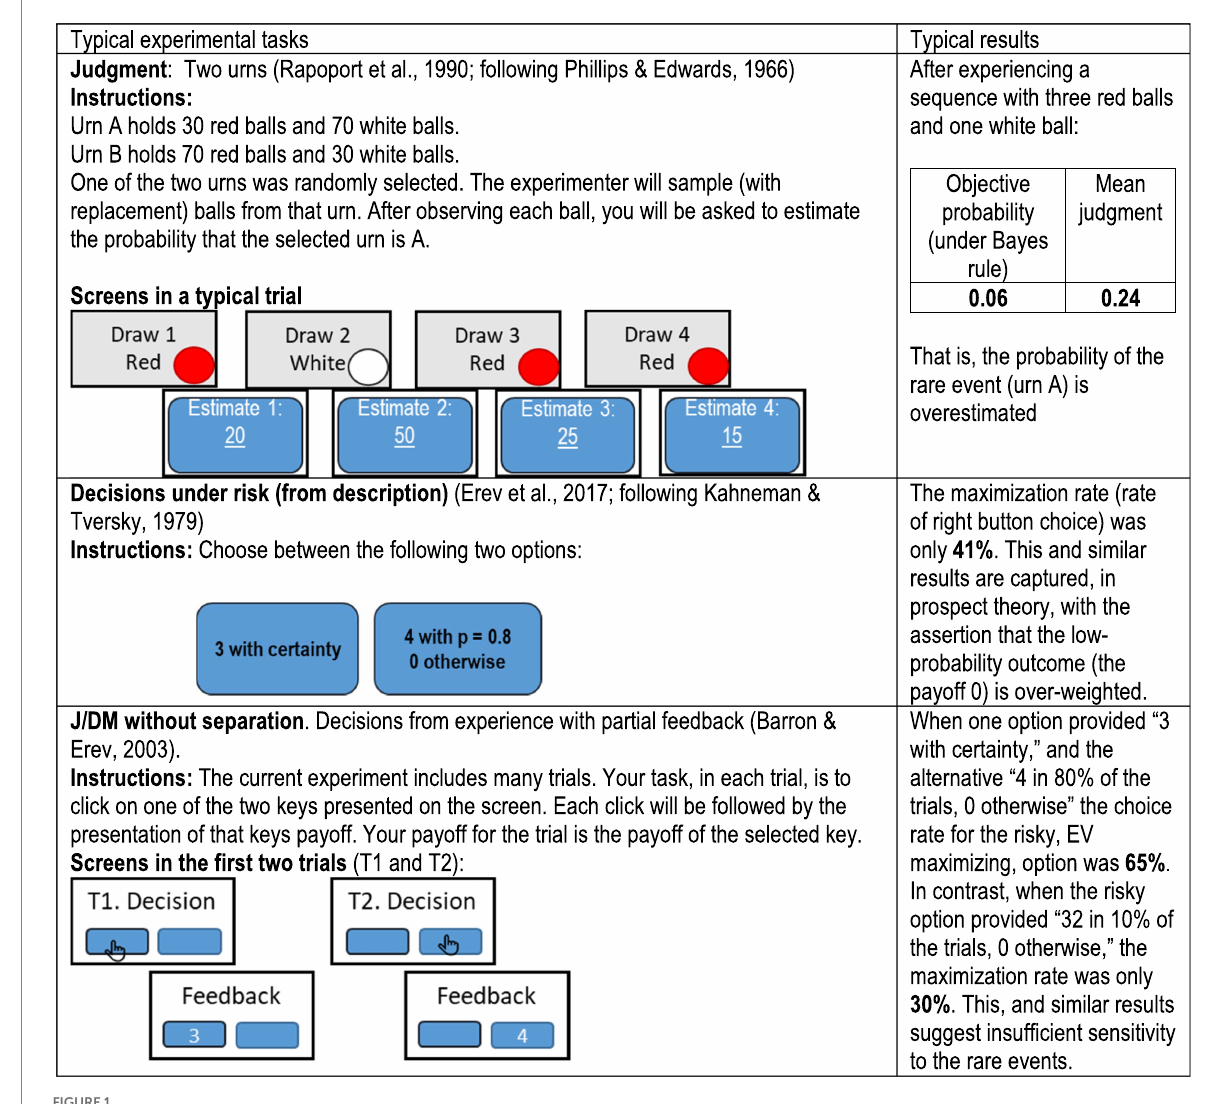
FIGURE 1 Examples of studies of judgement and decision making with and without the J/DM